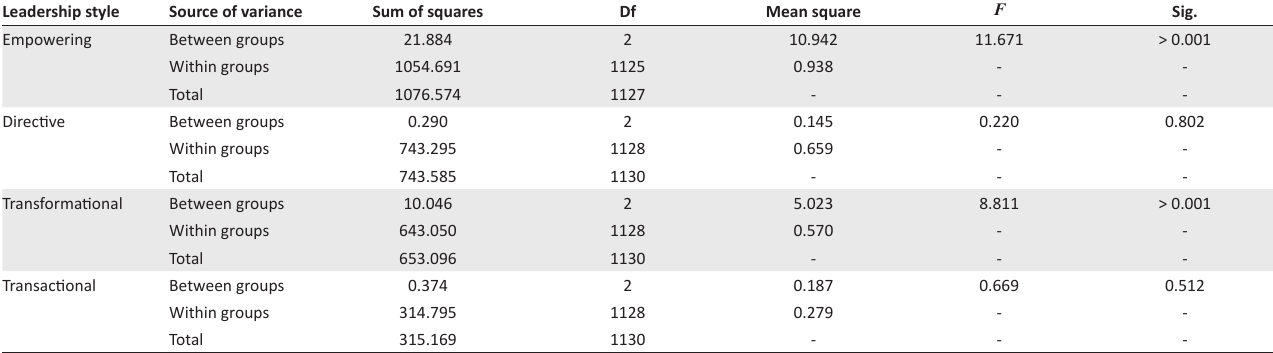
TABLE 6: One-way analysis of variance: Mean score differences across generations. Leadership style